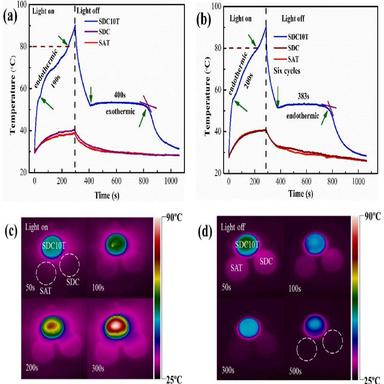
Temperature-time curves (a) and temperature-time curves (b) after six lighting–cooling cycles; temperature distribution images (c) and (d) of SAT, SDC and SDC10T.